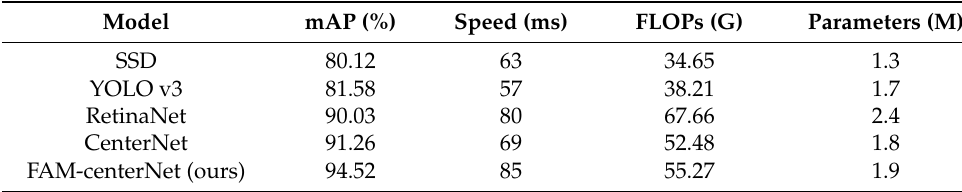
Table 6. Comparison against state-of-the-art object detection